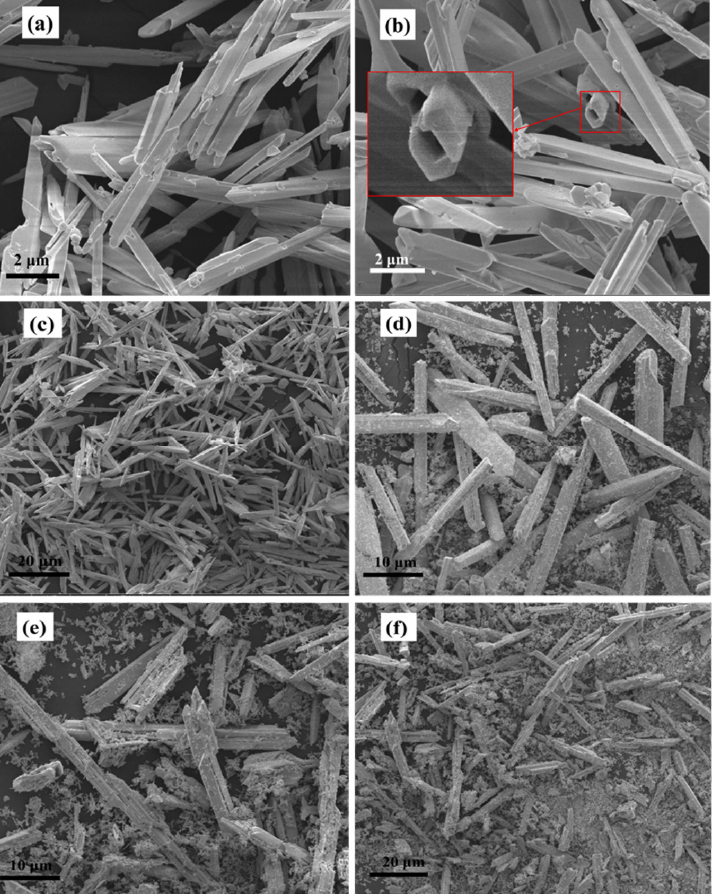
Figure 5. SEM images of the samples prepared at 140 °C for 10 h in the en–water mixture with various ratios of V en :V water : ( a ) 1:7, ( b , c ) 2:6, ( d ) 4:4, ( e ) 5:3, and ( f ) 6:2.